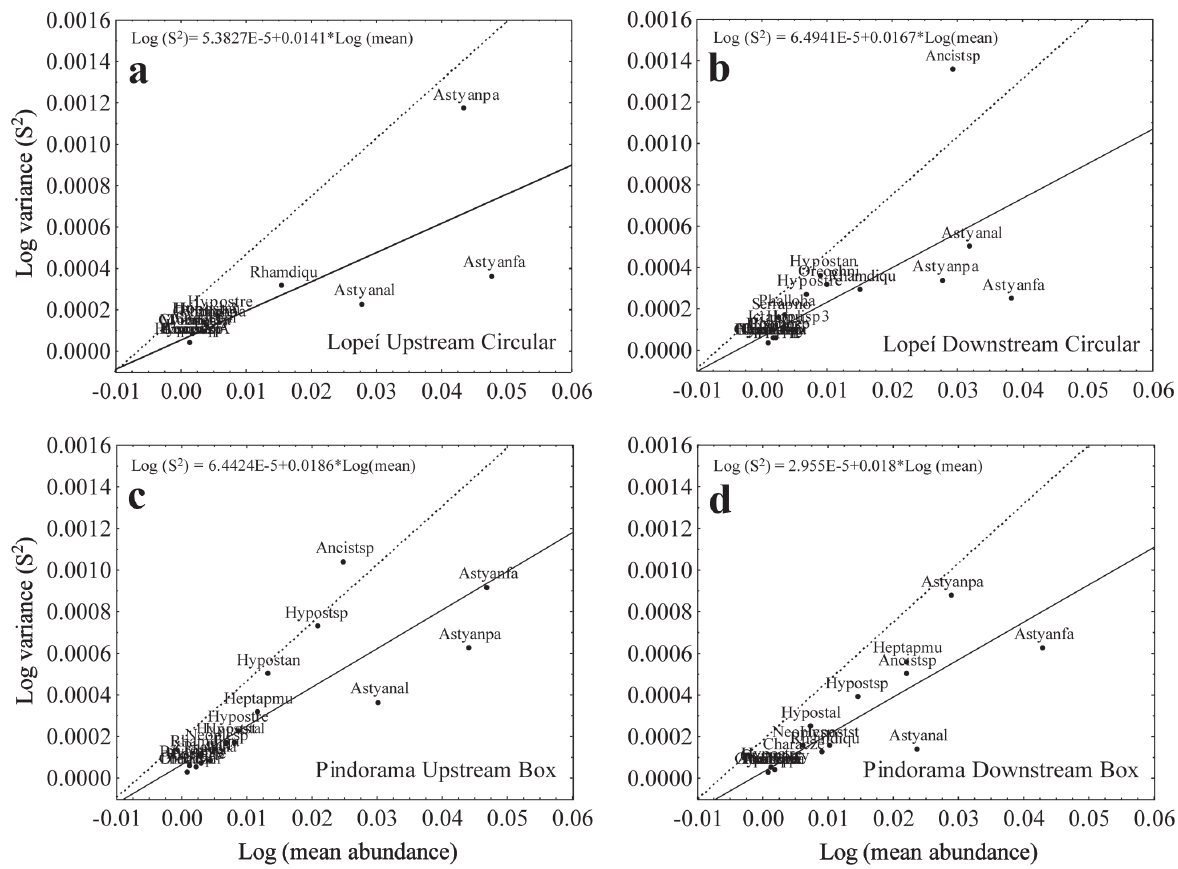
Fig. 12. Spatial aggregation of fish species in the sampled stretches of the Lopeí stream - circular culvert ( a - b ) and Pindorama stream - box culvert ( c - d